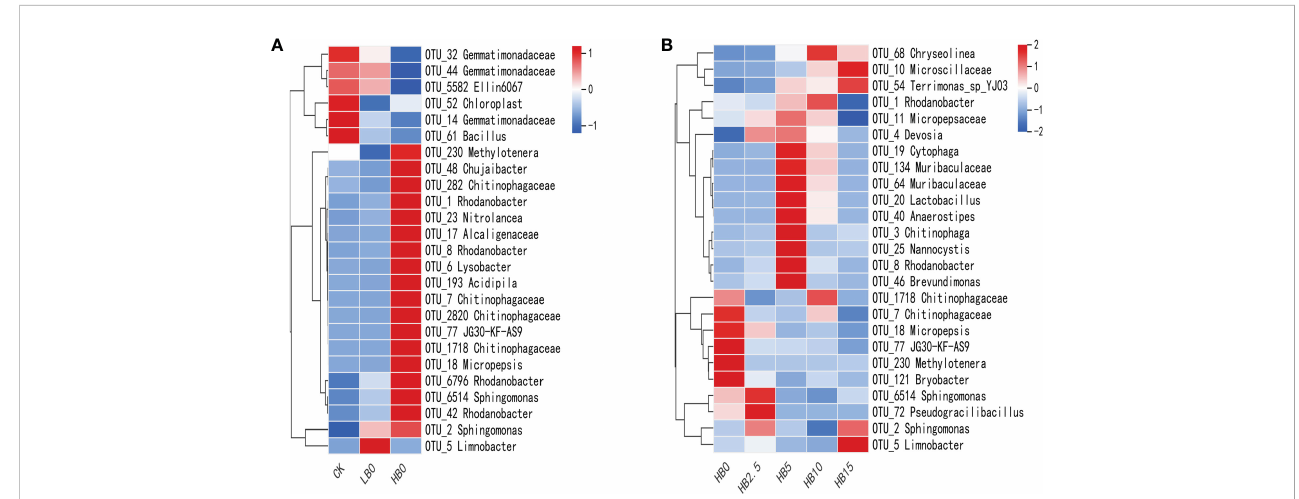
FIGURE 5 Effects of Pb and CSB on bacterial communities among treatments. (A) Most abundant 25 taxa within the treatment identi fi ed from CK vs . HB0 SIMPER analysis. (B) Most abundant 25 taxa within treatments of combined HB0 vs . HB5 SIMPER analyses.